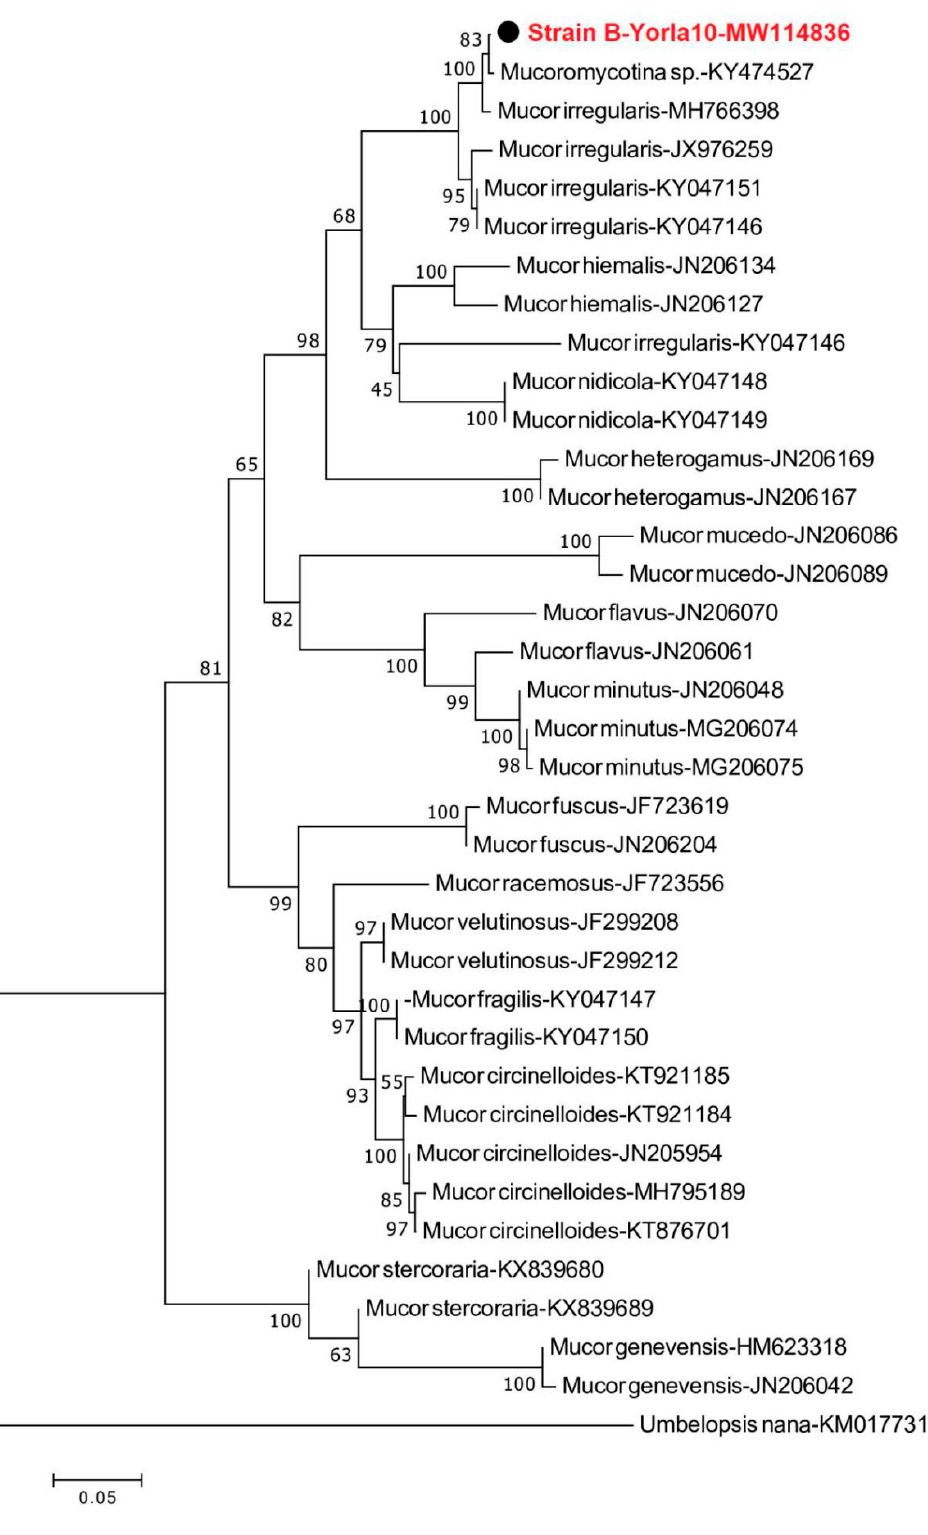
Figure 1. Neighbour-joining phylogenetic tree showing the relationship between the Mucor sequence from strain B-Yorla10 isolated from oil-contaminated soil in this study and selected database relatives. Kimura 2-parameter distances were used. Bootstrap values are based on percentages of 1000 replicates. The tree was rooted with Umbelopsis nana as